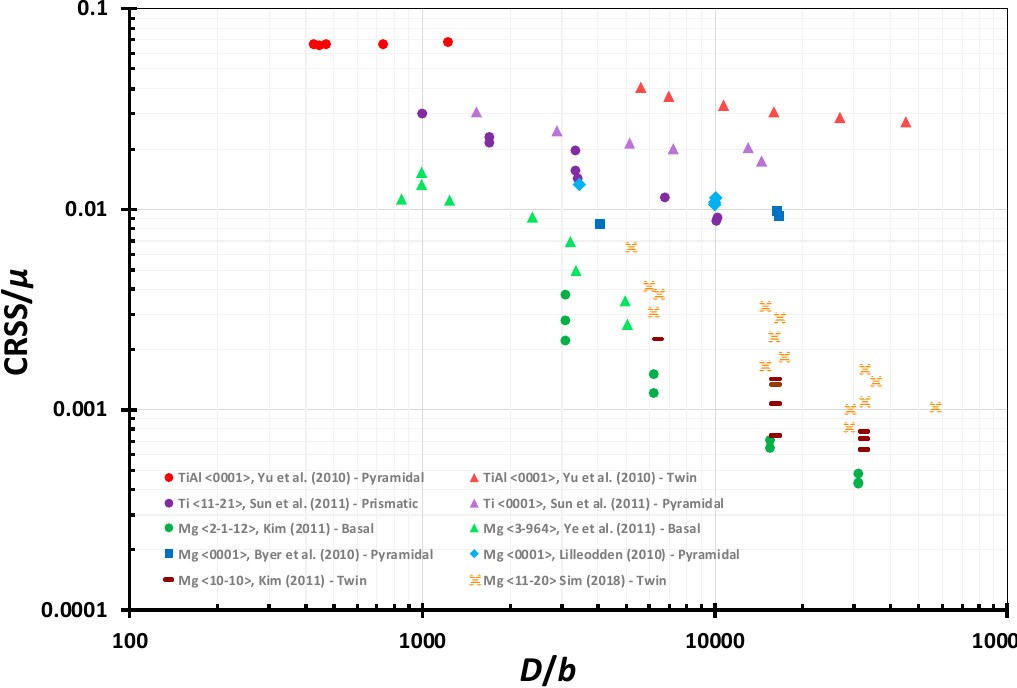
Figure 6. Variation of the critical resolved shear stress normalized by the shear modulus versus the sample diameter normalized by the Burgers vector in HCP metals. The original experimental data are reported by Byer et al. [47], Yu et al. [49], Lilleodden [46], Ye et al. [48], Sun et al. [45], Kim [50], and Sim et al. [51].